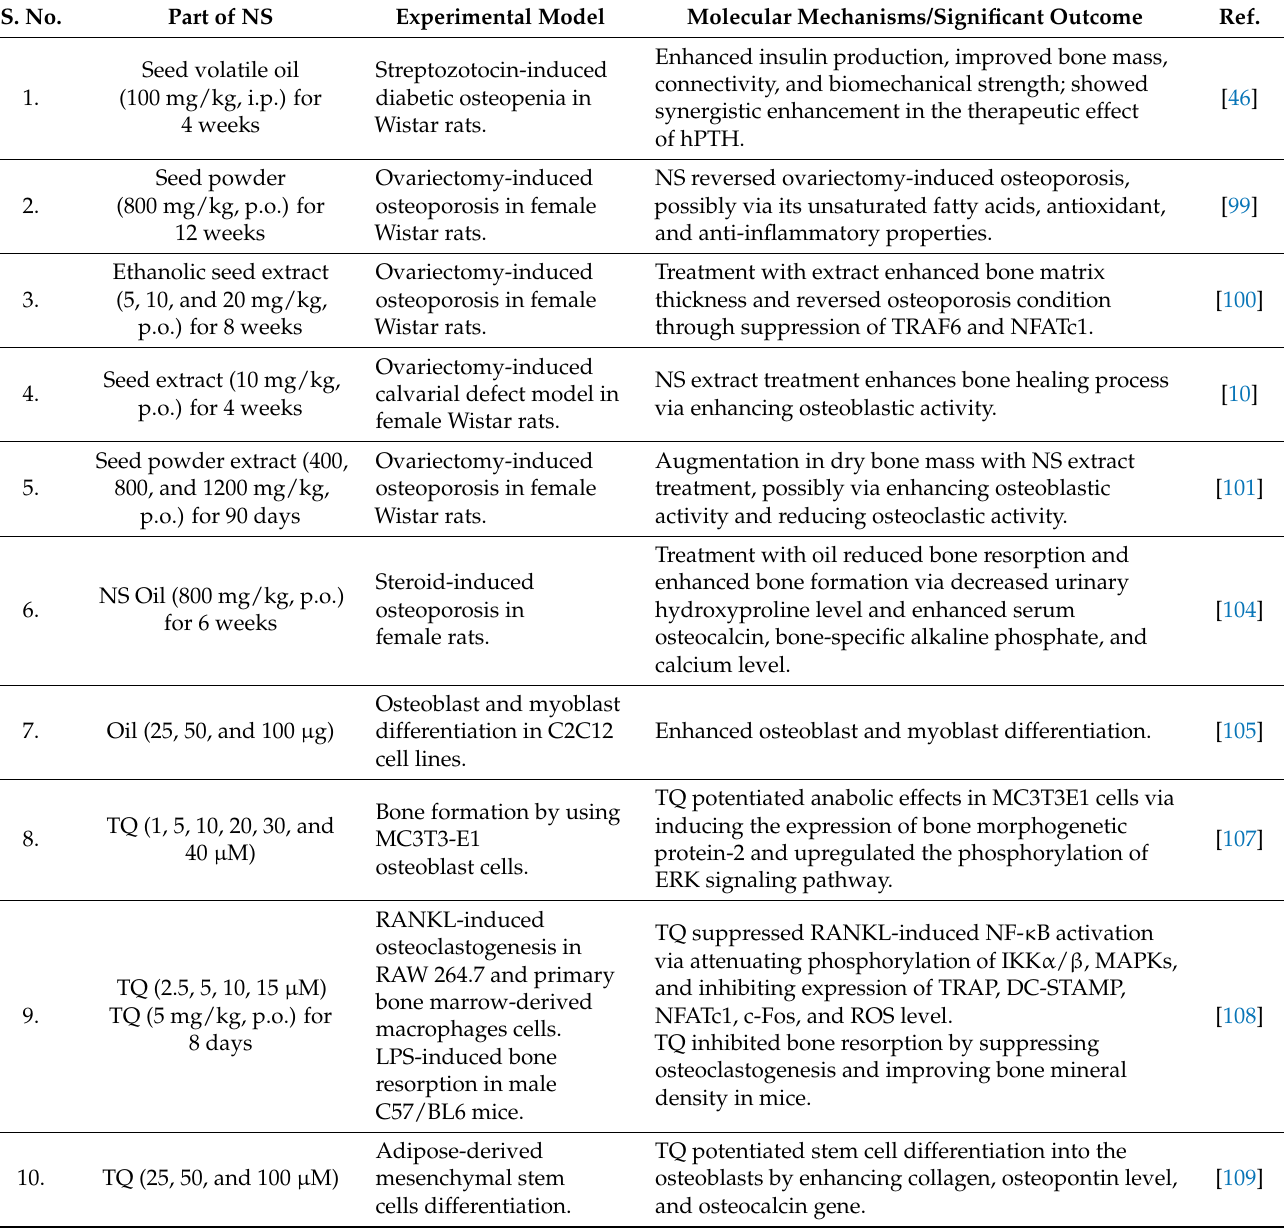
Table 1. Summary of the pharmacological profile of N. sativa and its constituent TQ, promising in the management of